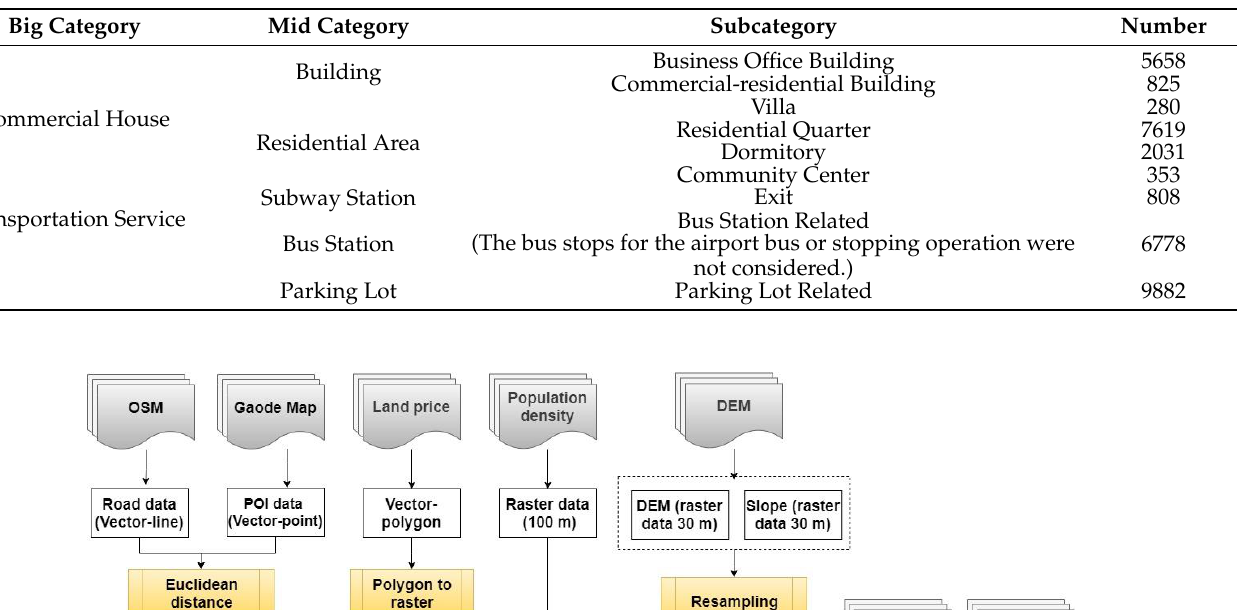
Table 2. List of POI data used.